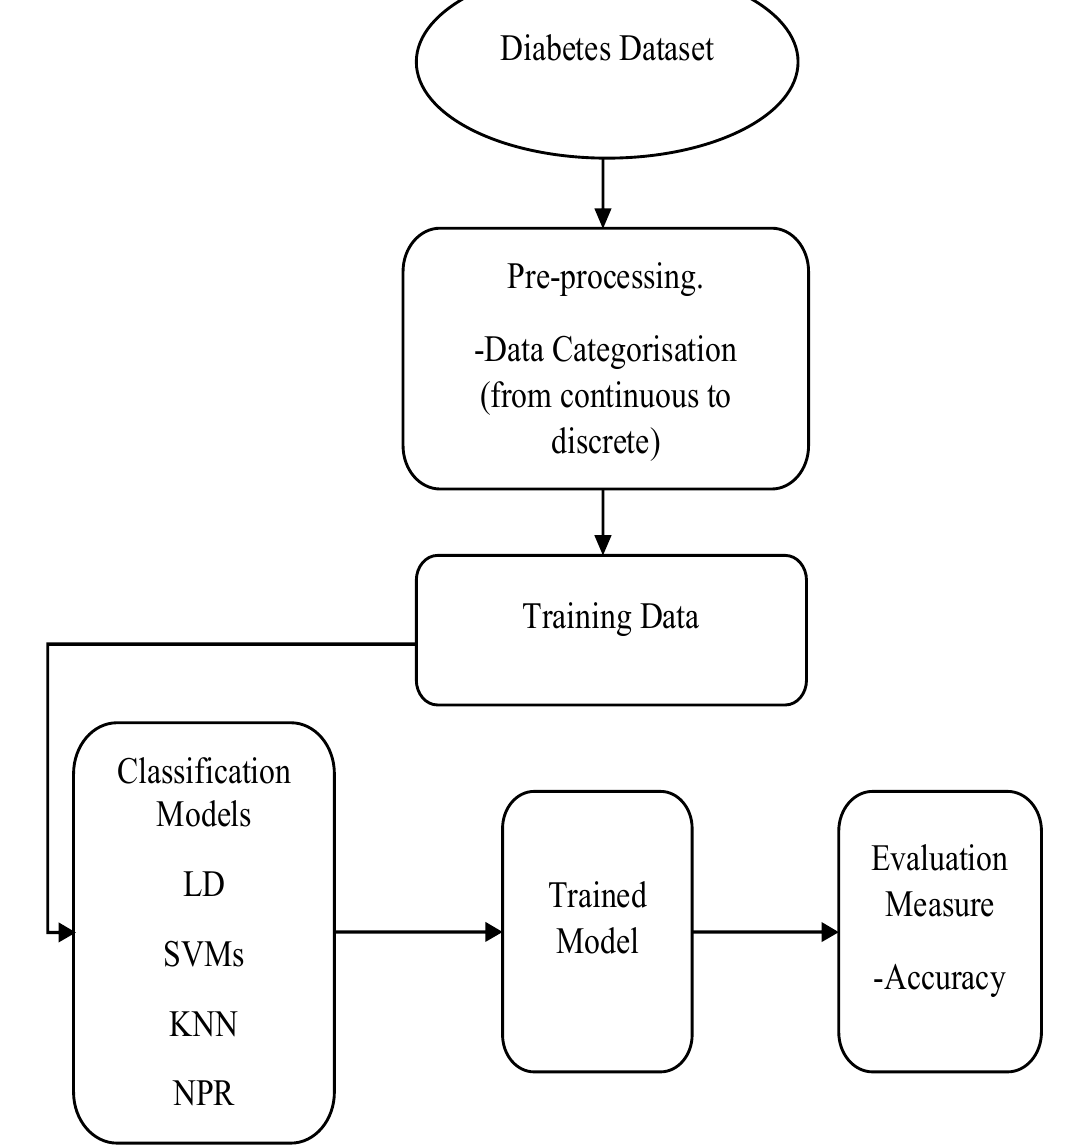
Figure 1. Flowchart of the training process of the classification models. For the SVM classification method, the characteristics of this algorithm regarding the kernel function, kernel scale, and other parameters are given in Table 2. One of these parameters is the (box constraint level) which is a parameter that controls the maximum penalty imposed on margin-violating observations and helps in avoiding overfitting. If the box constraint level is increased, then fewer support vectors will be assigned; however, increasing the box constraint can result in longer training